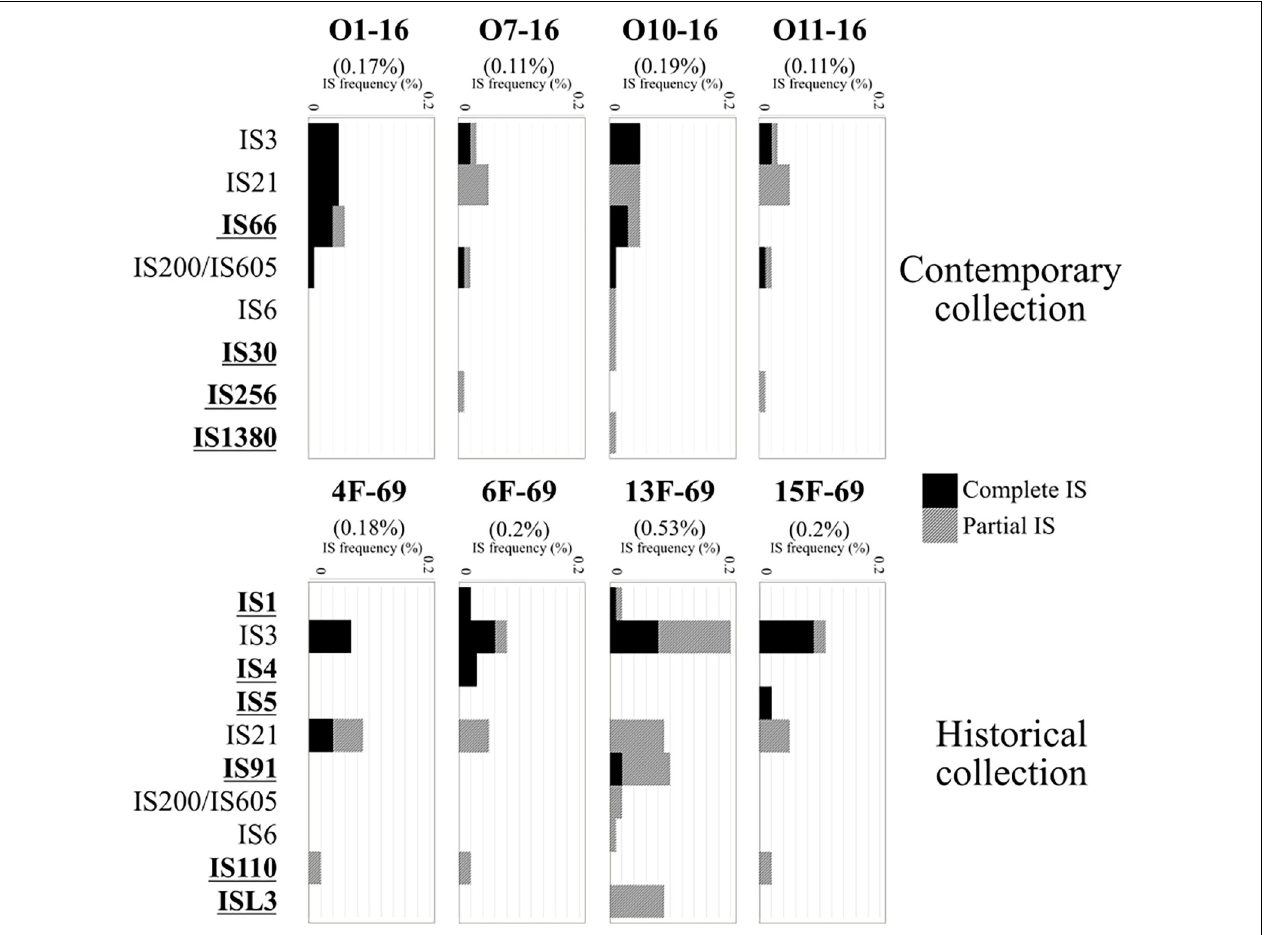
FIGURE 3 | Insertion sequences (ISs) detected in the eight Serratia marcescens studied isolates and their frequency in the annotated genomes, represented as IS bp/total genome bp (%). Total IS frequency in each genome is expressed in parentheses. ISEScan output included integral ISs and partially present ISs (black and gray bars, respectively). Bold, underlined IS labels were found only in one collection but not in the